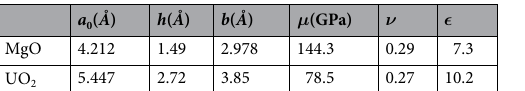
Table 2. Parameters describing the interaction of jog pairs along a screw dislocation for MgO and UO 2 . a 0 is lattice constant. h is jog height. b is the length of Burgers vector. μ is shear modulus. ν is Poisson’s ratio.  is the relative permittivity of the material. μ , ν , and  are calculated using GULP 35